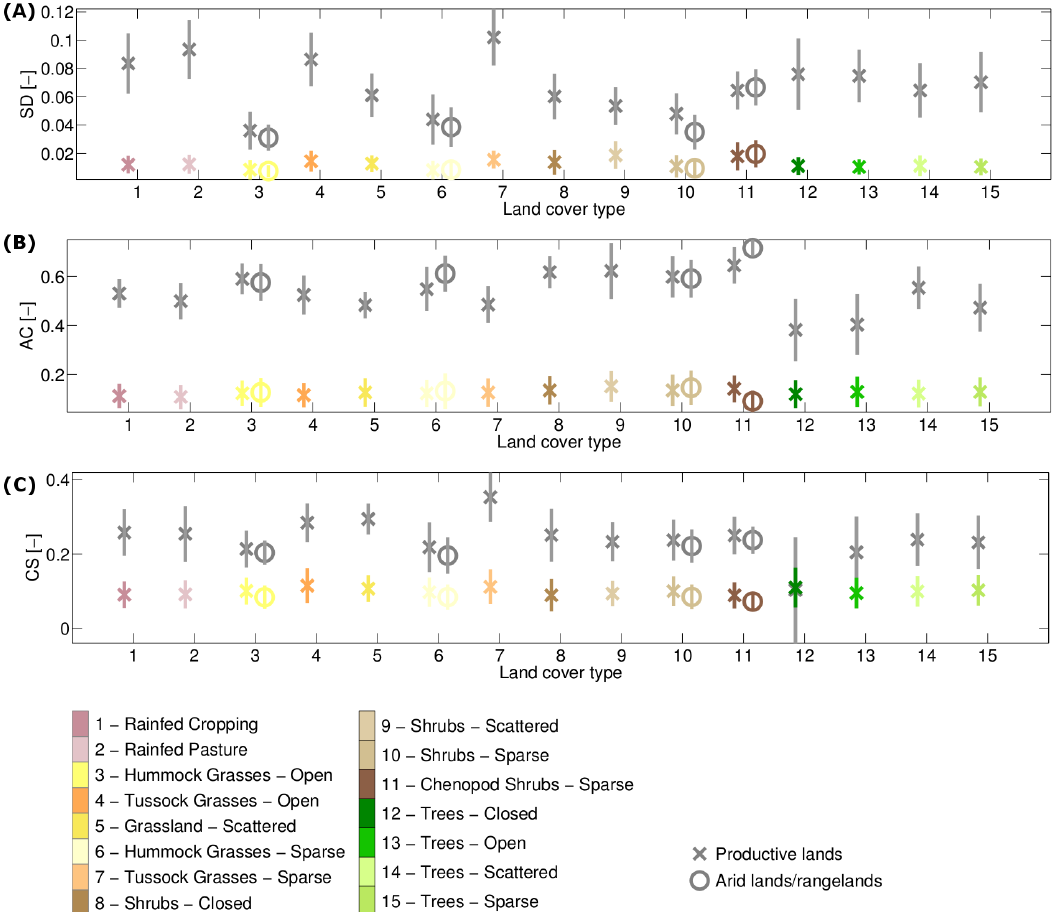
Figure 6. Overview of the mean (symbol) and spatial variability (error bar) of the stability (grey) and range in stability (color) per land cover type for three stability metrics: ( A ) standard deviation (SD); ( B ) auto-correlation at lag one (AC); and ( C ) correlation of the NDVI anomaly with the Standardized Precipitation and Evapotranspiration Index (CS). The shape of the symbols represent the disturbance regime/land use: arid lands/rangelands (o) and productive lands (x). The pixels for which the stability metric derived over the whole time series length was not significant were not taken into account, and land cover types containing less than 100 pixels were